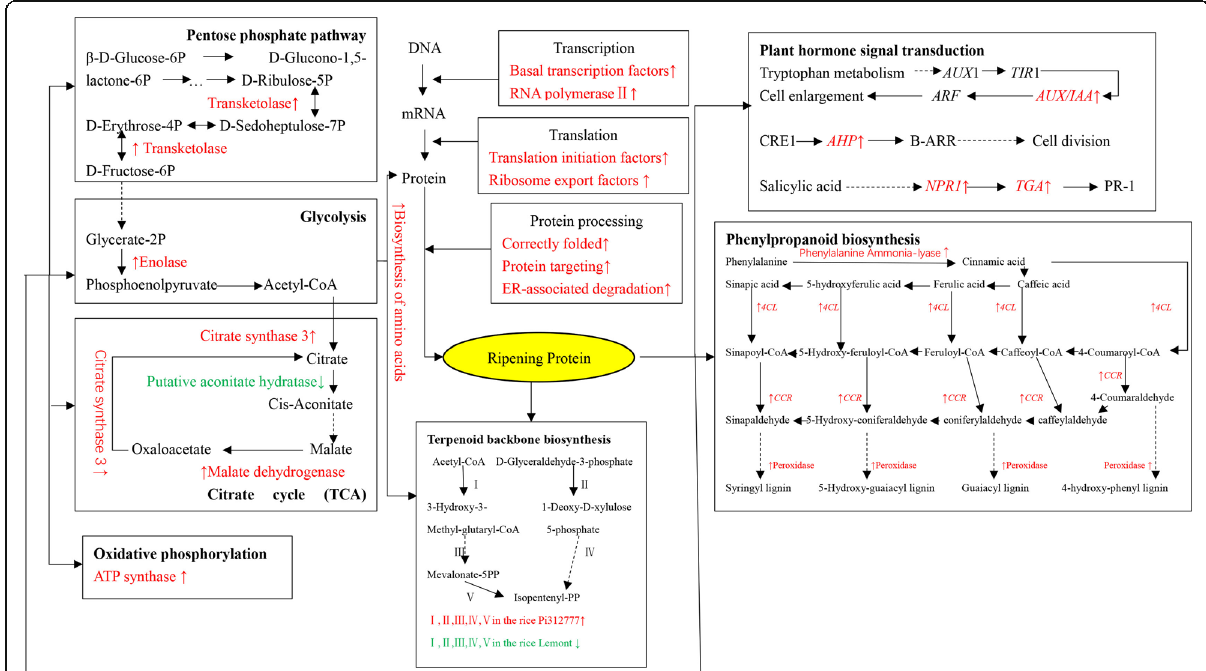
Fig. 6 Schematic molecular pathway depicting the changes in the rice root transcriptome under induction treatment by barnyard grass root exudates. The red color represents upregulated genes, and the green color represents downregulated genes. AUX/IAA , auxin-responsive protein IAA; ARF , auxin response factor; AHP , histidine-containing phosphotransfer protein; NPR 1, regulatory protein NPR1; TGA , transcription factor TGA; I: hydroxymethylglutaryl-CoA reductase; II: 1-deoxy-D-xylulose-5-phosphate synthase; III: mevalonate kinase; IV: isopentenyl-diphosphate delta- isomerase; V: diphosphomevalonate decarboxylase; 4CL , 4-coumarate-CoA ligase; CCR , cinnamoyl-CoA